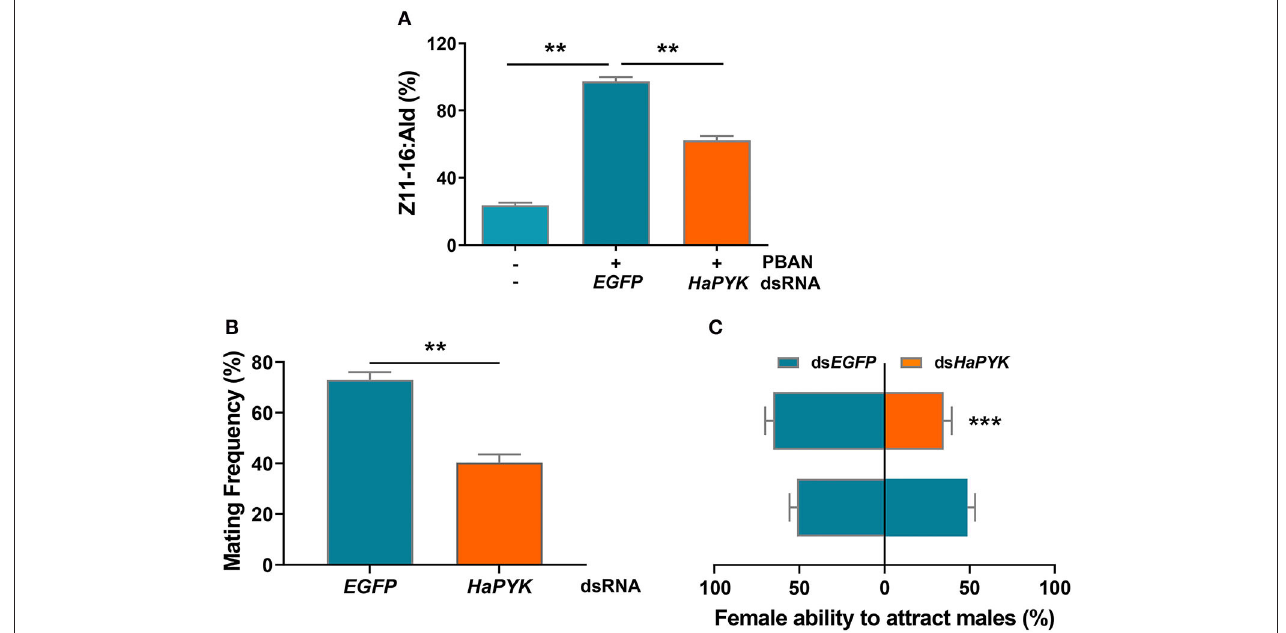
FIGURE 3 | Knockdown of HaPYK reduced the content of sex pheromone and mating behaviors. (A) The effect of HaPYK knockdown on sex pheromone production. (B,C) The effect of HaPYK knockdown on mating frequency and attractant ability. Error bars indicate the mean ± s.d. of three independent biological experiments, ** P < 0.01, *** P < 0.001 (Student’s t -test).